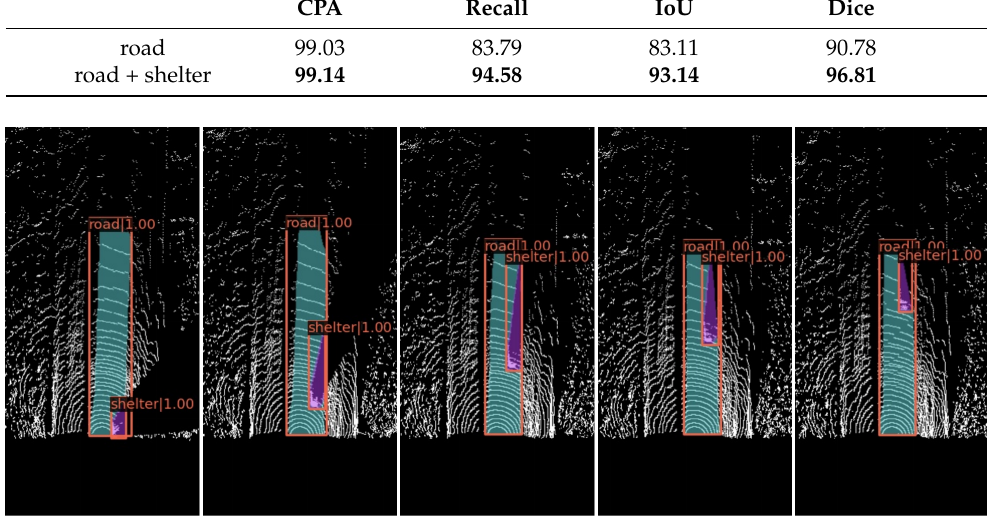
Figure 13. From left to right, the figure shows a car passing by our UGV.